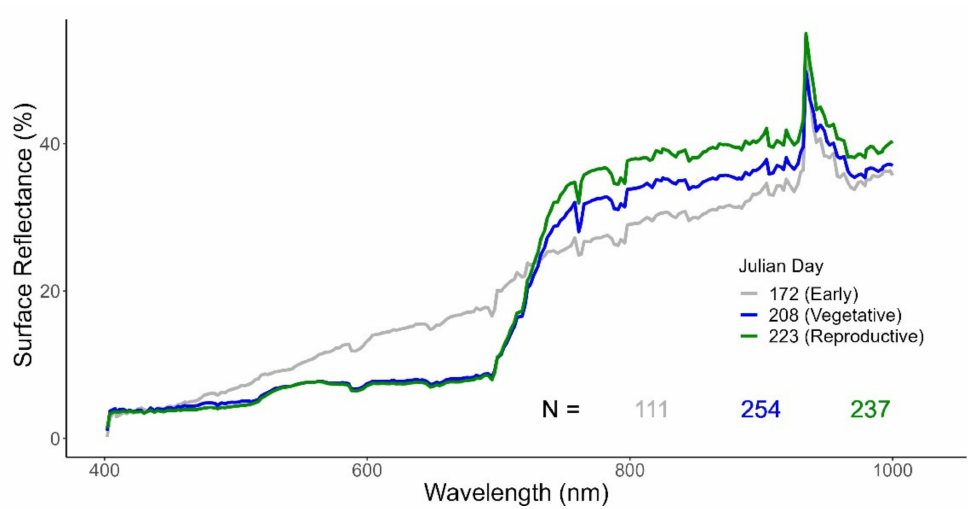
Figure 8. DESIS Soybean Spectra for the year 2019 (wet year). DESIS soybean spectra on Julian Days 172 (June), 208 (July), and 223 (August) in Oklahoma,